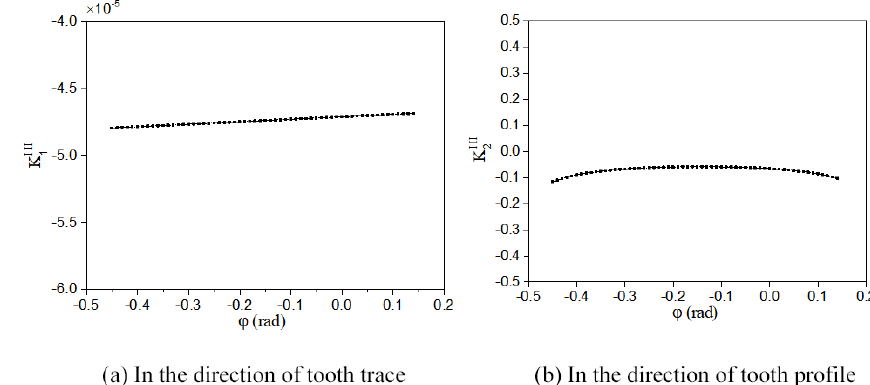
Figure 6. The variations on induced normal curvature of gear pairs.